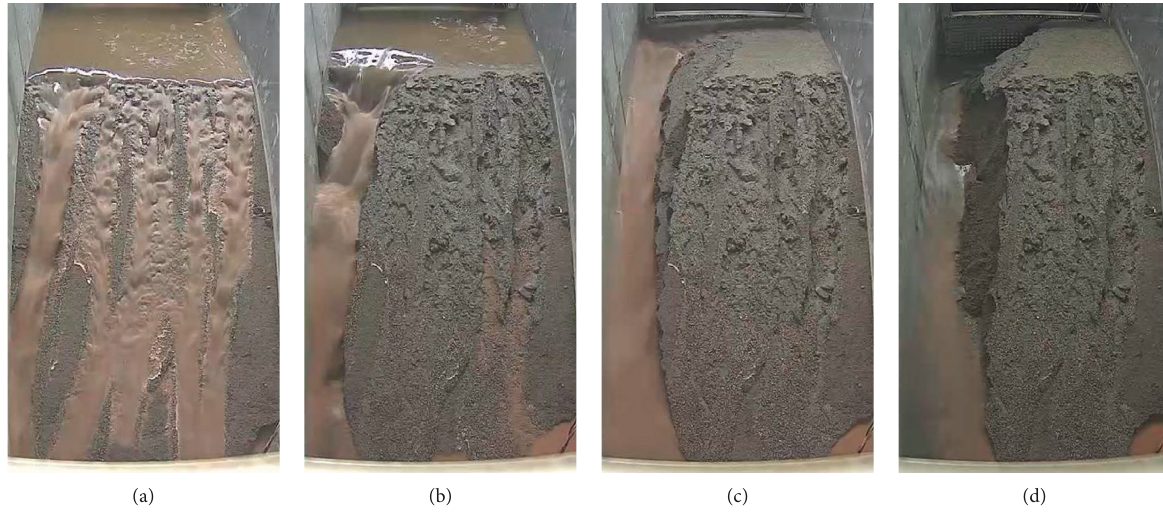
Figure 4: The breaching process of the tailings dam model.